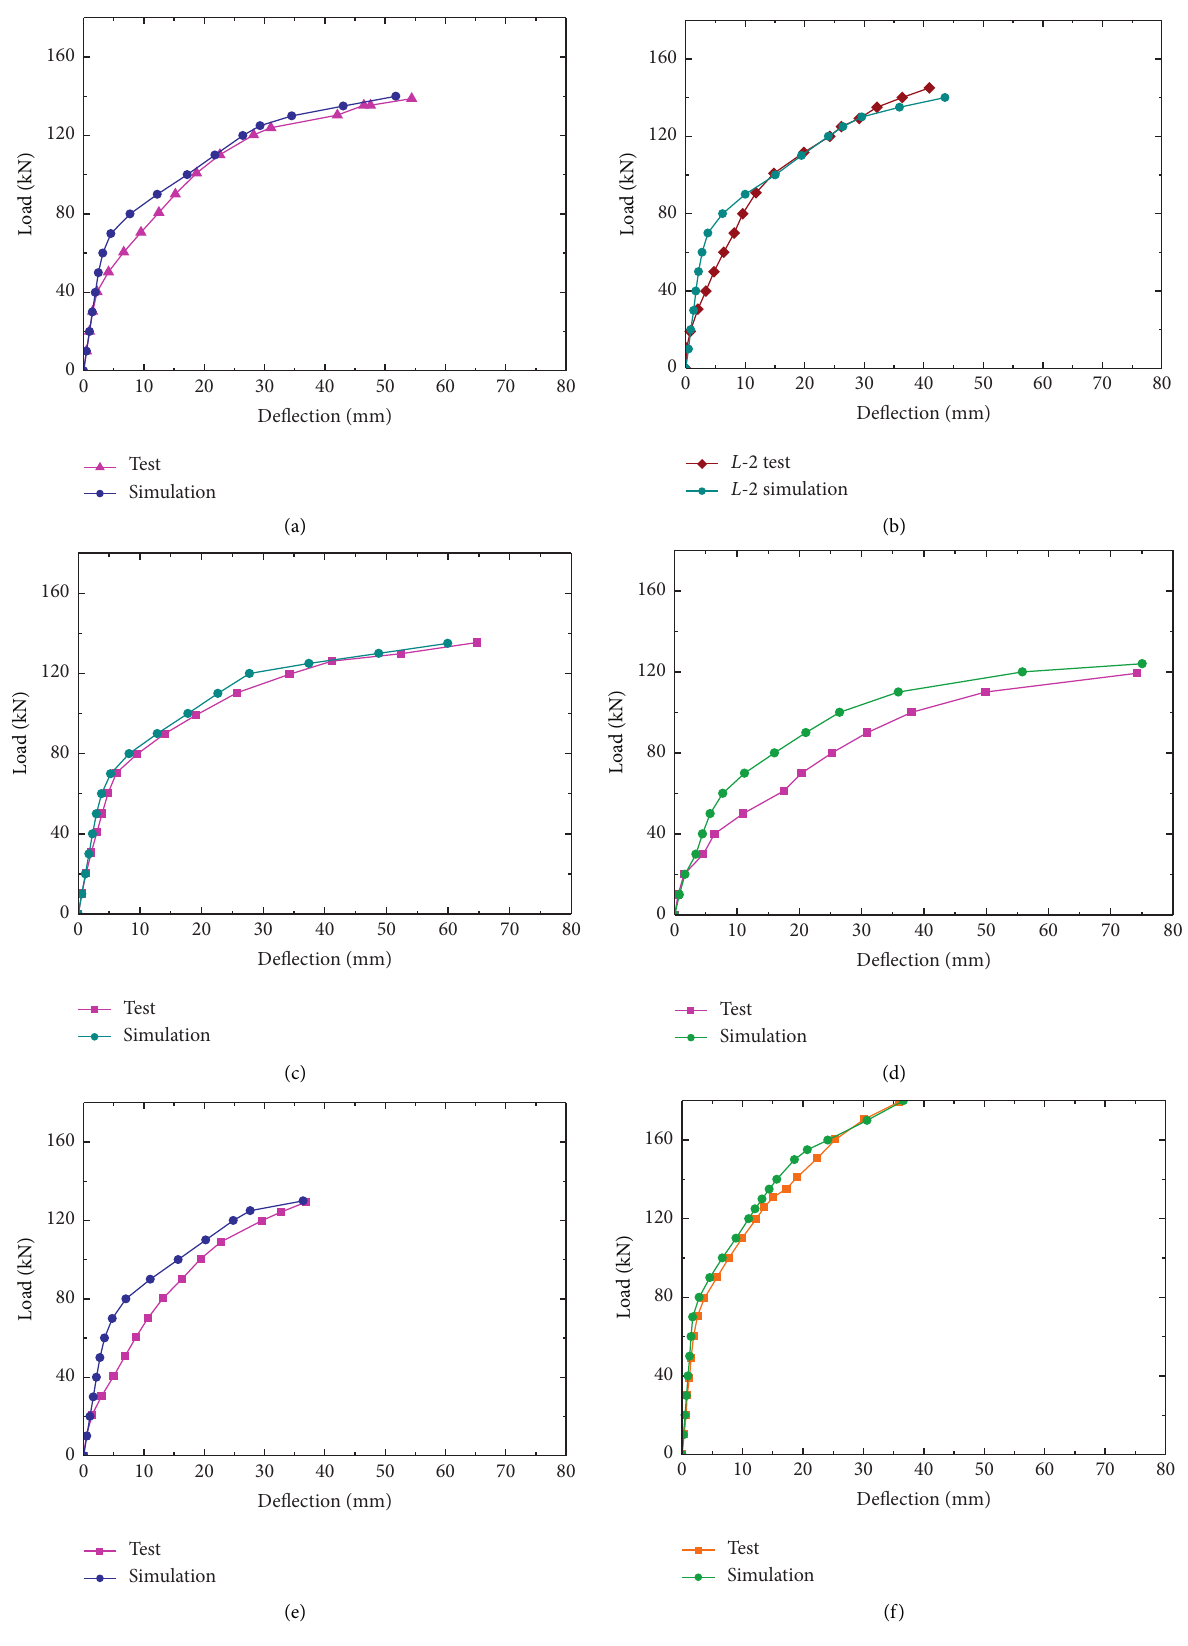
Figure 17: Comparison of test and numerical simulation results: (a) specimen 1, (b) specimen 2, (c) specimen 3, (d) specimen 4, (e) specimen 5, and (f) specimen